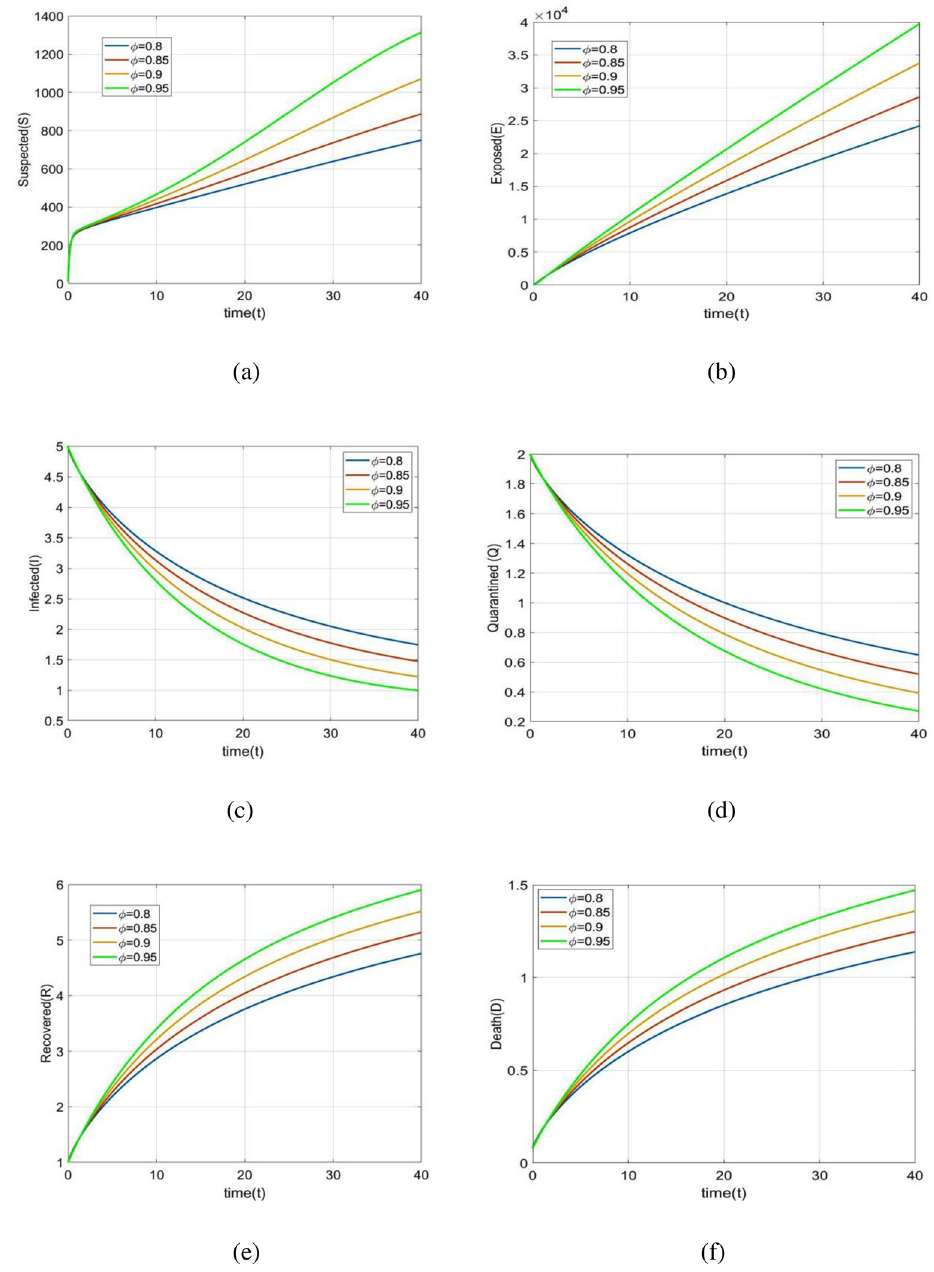
Fig 3. Dynamical behavior. Dynamic of all classes over time for various values of ϕ = 0.8, 0.85, 0.90, 0.95.